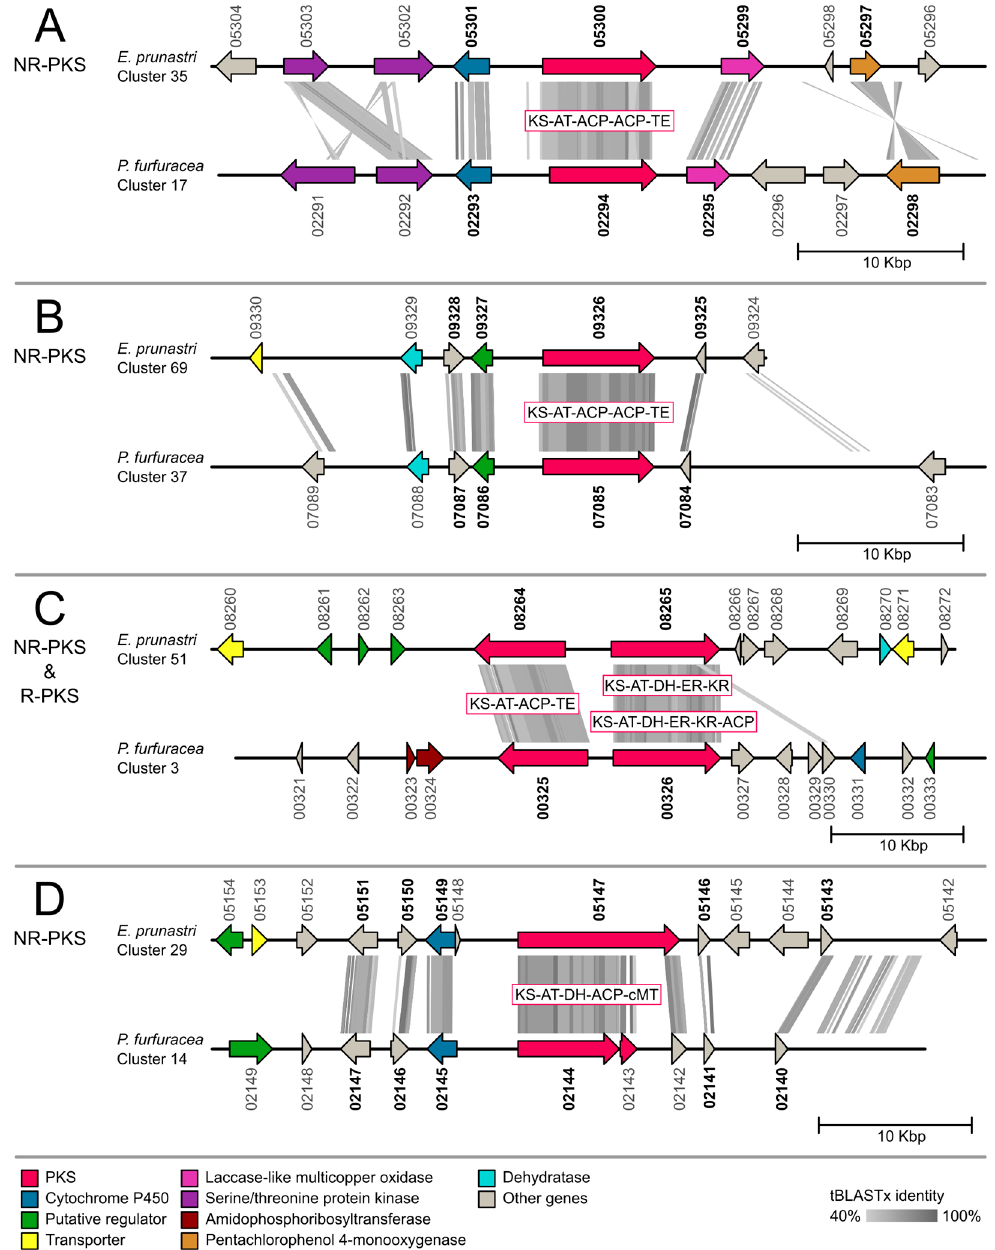
Figure 3. Synteny plots of biosynthetic gene clusters with an ortholog non-reducing polyketide synthase (NR-PKS) core gene in Evernia prunastri and Pseudevernia furfuracea . Orthologous genes identified with the reciprocal best hit (RBH) approach are highlighted in bold. ACP = Acyl carrier protein; AT = Acyltransferase; cMT = C-Methyltransferase; DH = Dehydratase; ER = Enoylreductase; KR = Ketoreductase; KS = Ketosynthase; TE = Thioesterase.